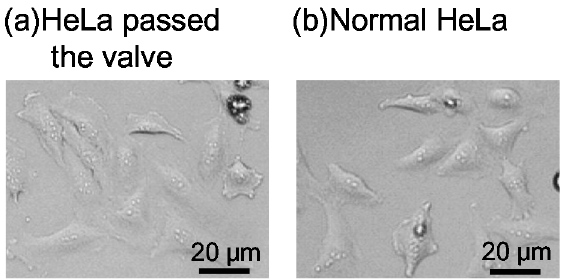
Figure 17. Day-3 morphologies of the HeLa cells ( a ) passed; and ( b ) not passed (“Normal”) through the microvalve.